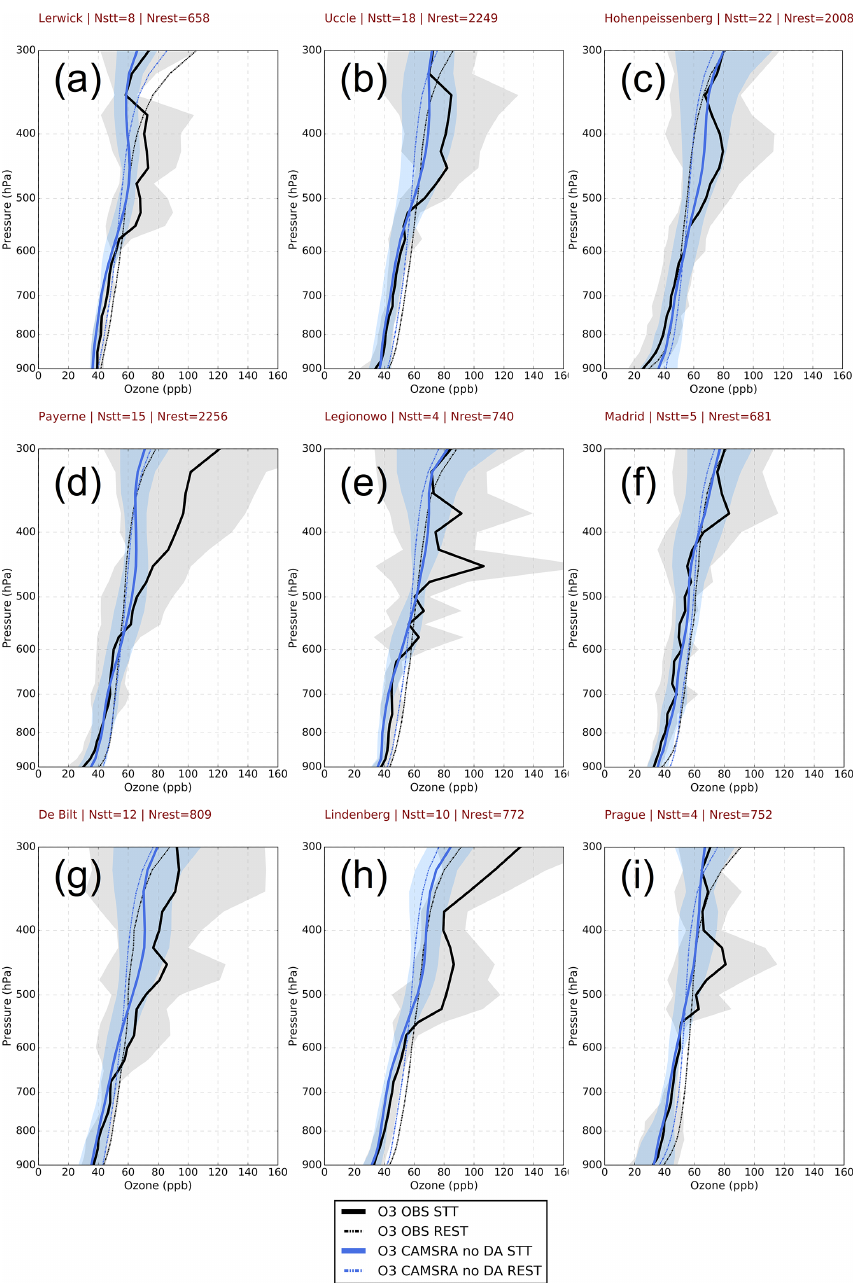
Figure 8. Vertical profiles of observed (black) and CAMSRA no DA (blue) ozone concentrations (ppb) during STT events (thick solid line) and during the rest of the events (thin dashed line) at the WOUDC ozonesonde stations of (a) Lerwick (UK), (b) Uccle (Belgium), (c) Hohenpeissenberg (Germany), (d) Payerne (Switzerland), (e) Legionowo (Poland), (f) Madrid (Spain), (g) De Bilt (the Netherlands), (h) Lindenberg (Germany), and (i) Prague (Czech Republic). The grey and light blue areas depict the ± 1 standard deviation of ozone vertical profiles during STT events in observations and CAMSRA no DA,